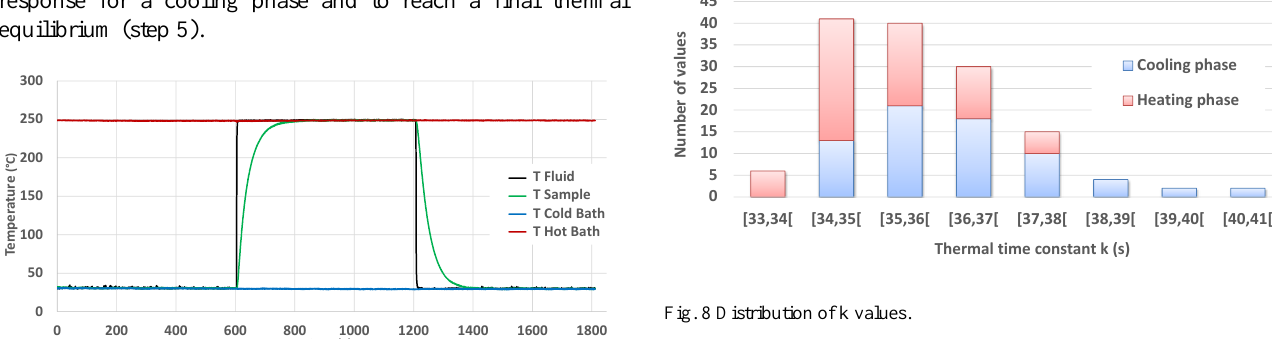
Fig. 8 Distribution of k values.